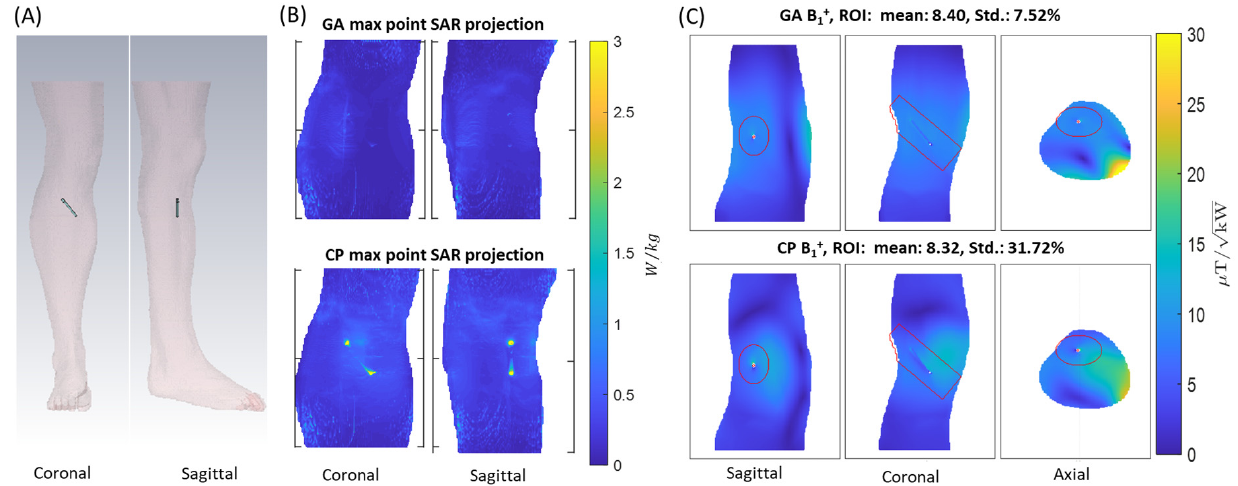
Figure 9. ( A ) Overview of the setup used for EMF simulations showing the positioning of the sample screw implant in the tibia of the human voxel model Duke. ( B ) Maximum point SAR projections obtained for the GA ( top ) and CP ( bottom ) approach for 1 W input power. ( C ) B + maps derived for slices through the center of the implant using the GA ( top ) and CP ( bottom ) approach. The ROI is highlighted in red.